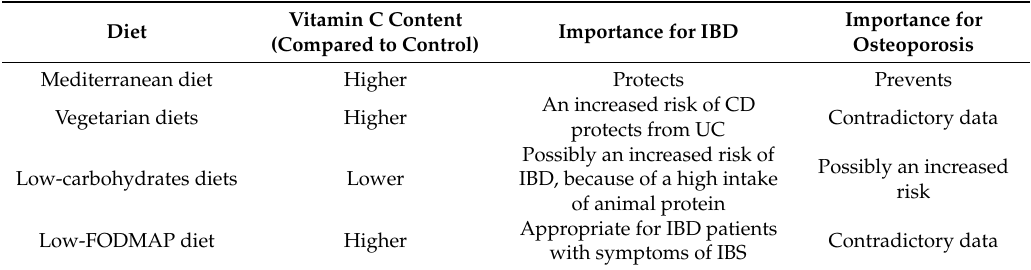
Table 4. Comparison of various